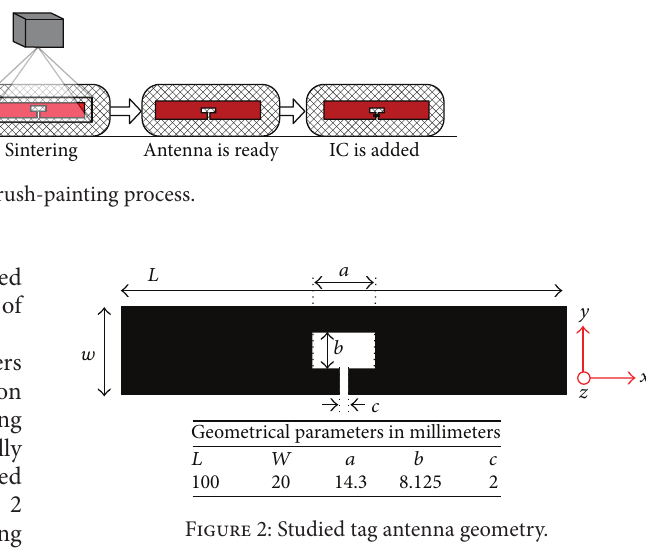
Figure 2: Studied tag antenna